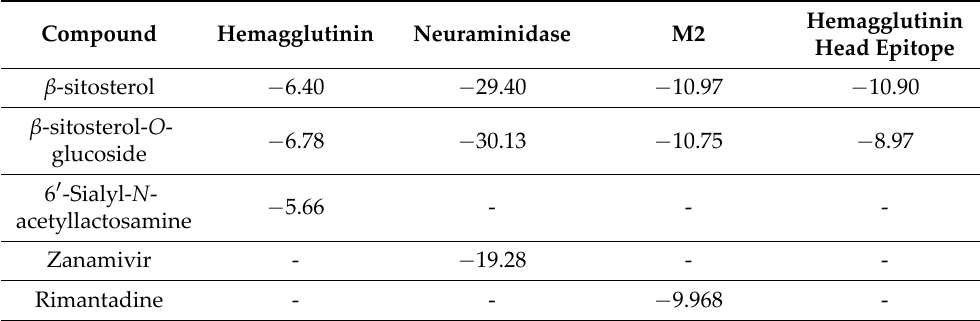
Table 4. Binding free energies ( ∆ G in Kcal/mol) of β ‑sitosterol, and β ‑sitosterol‑ O ‑glucoside, against hemagglutinin, neuraminidase, M2, and hemagglutinin head epitope proteins as compared to the reference